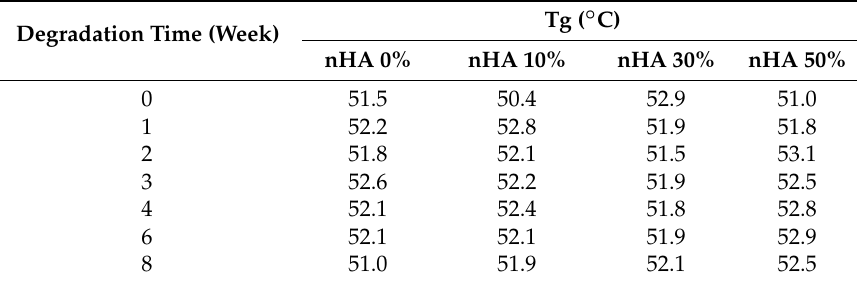
Table 4. Tgs of PLGA (75/25) and PLGA (75/25)/nHA composite scaffolds.